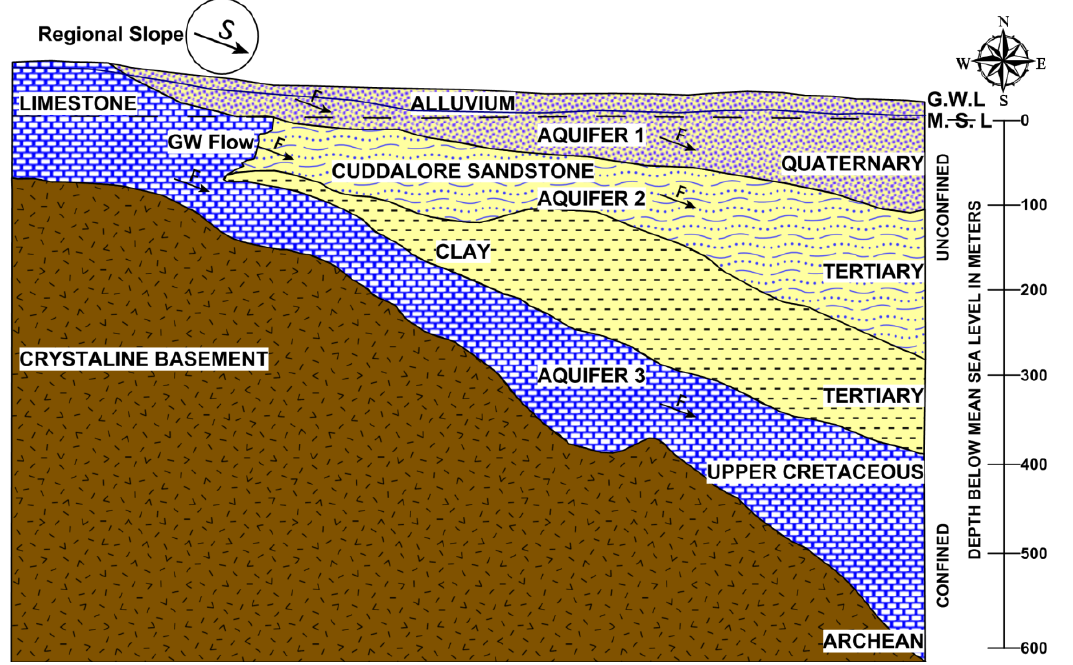
Figure 2. The hydrogeological profile and the information of groundwater flow.